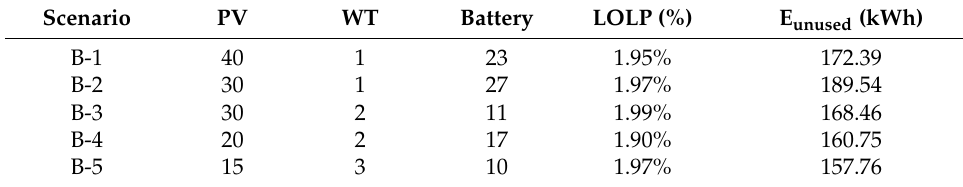
Table 1. Scenarios of hybrid system with batteries satisfying the preset criteria.